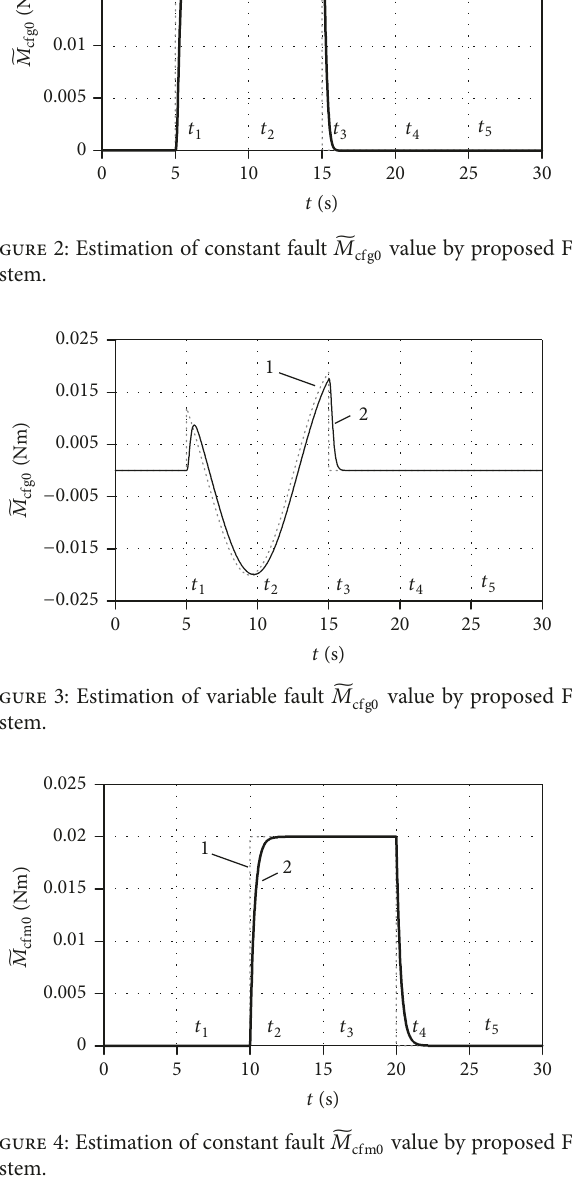
Figure7:Estimationofvariablefault